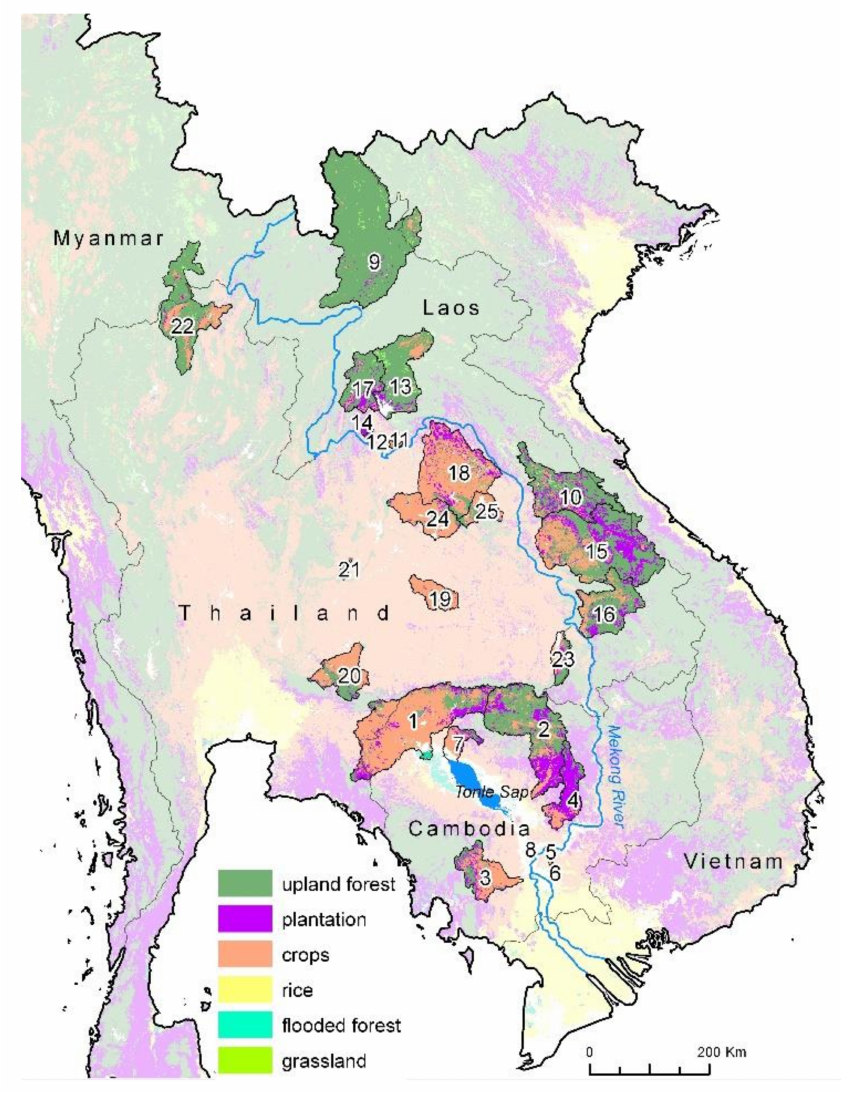
Figure 1. Land use cover in Cambodia, Laos, and Thailand in 2017. The watersheds we analyzed in this study are shown with bold colors, while areas outside of the watersheds are shaded. Watershed numbering corresponds to labels in Figures